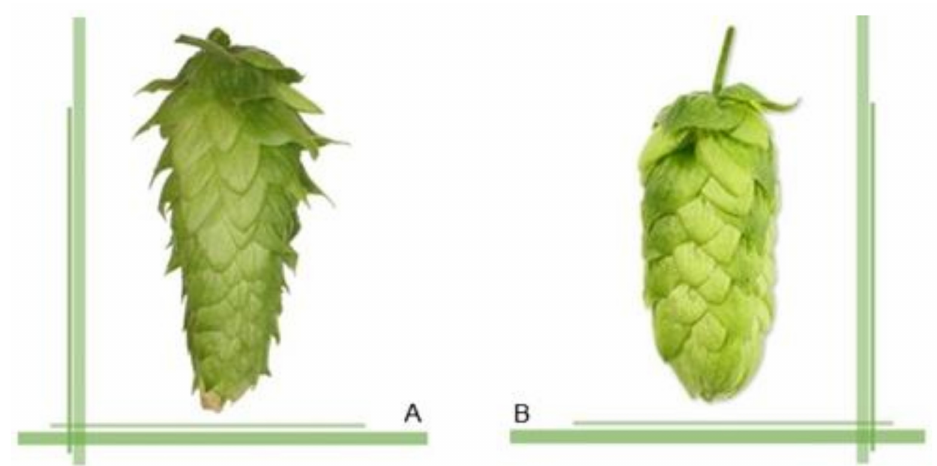
Figure 2. ( A ) H. lupulus L. “Chinook”; ( B ) H. lupulus L.